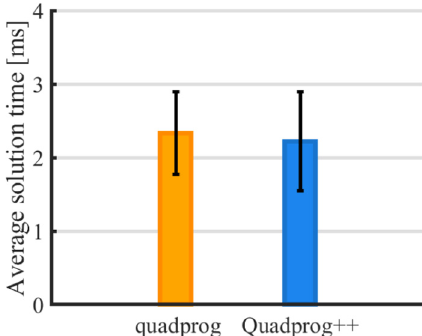
Figure 8 Comparison of the solution time of quadprog and Quadprog